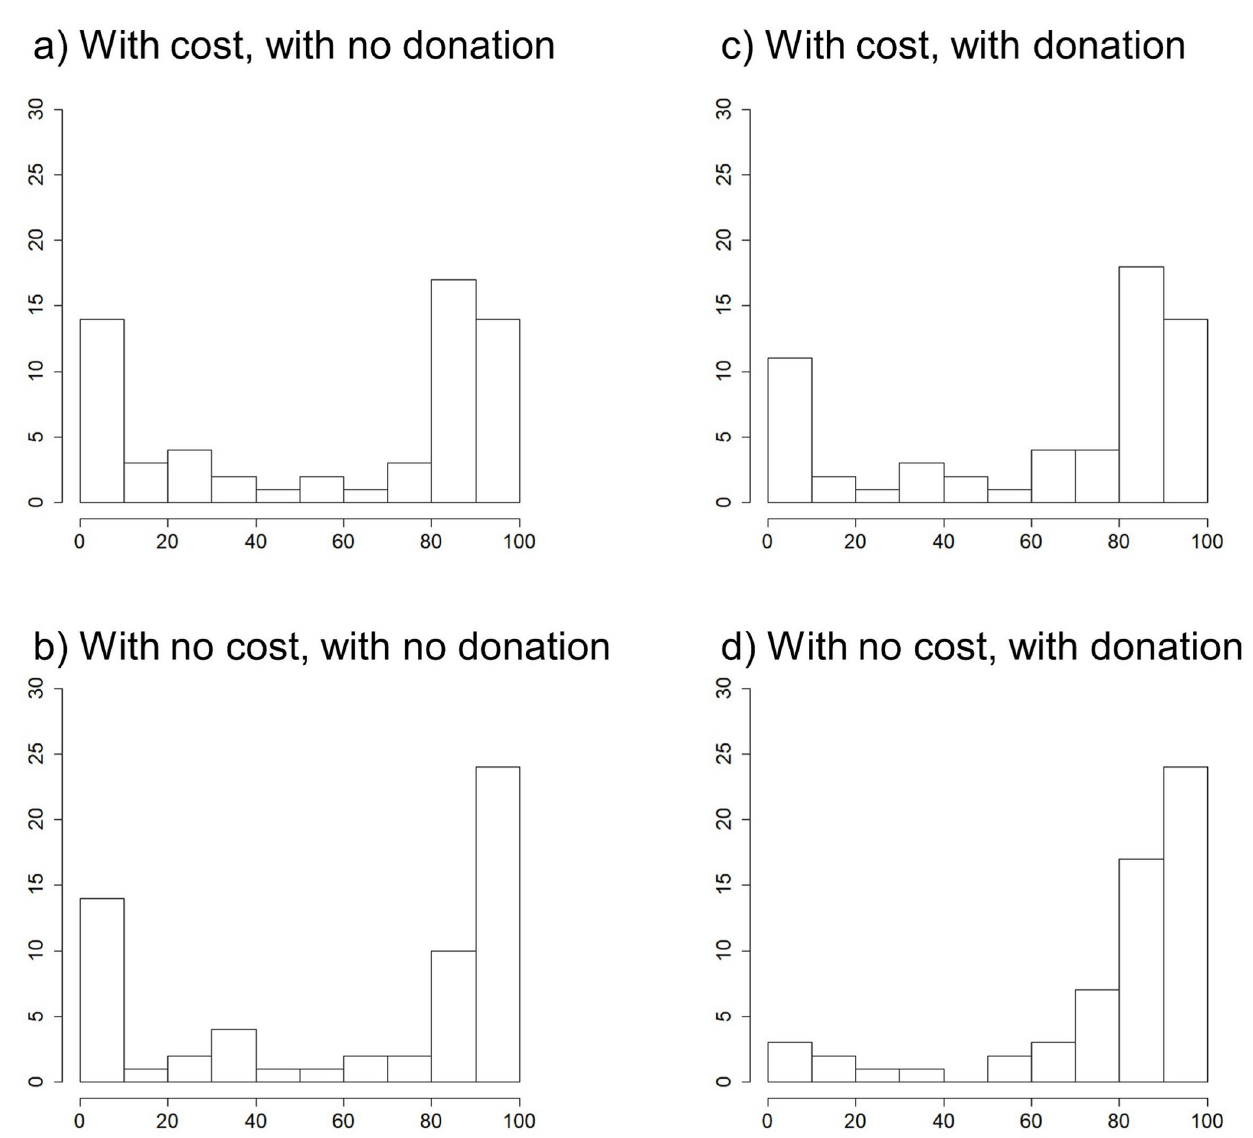
Fig 2. Distributions of correct answers in each treatment. Panel a, b, c and d show treatment A, B, C, D respectively. x axis shows the number of correct answers and y axis shows the number of participants.